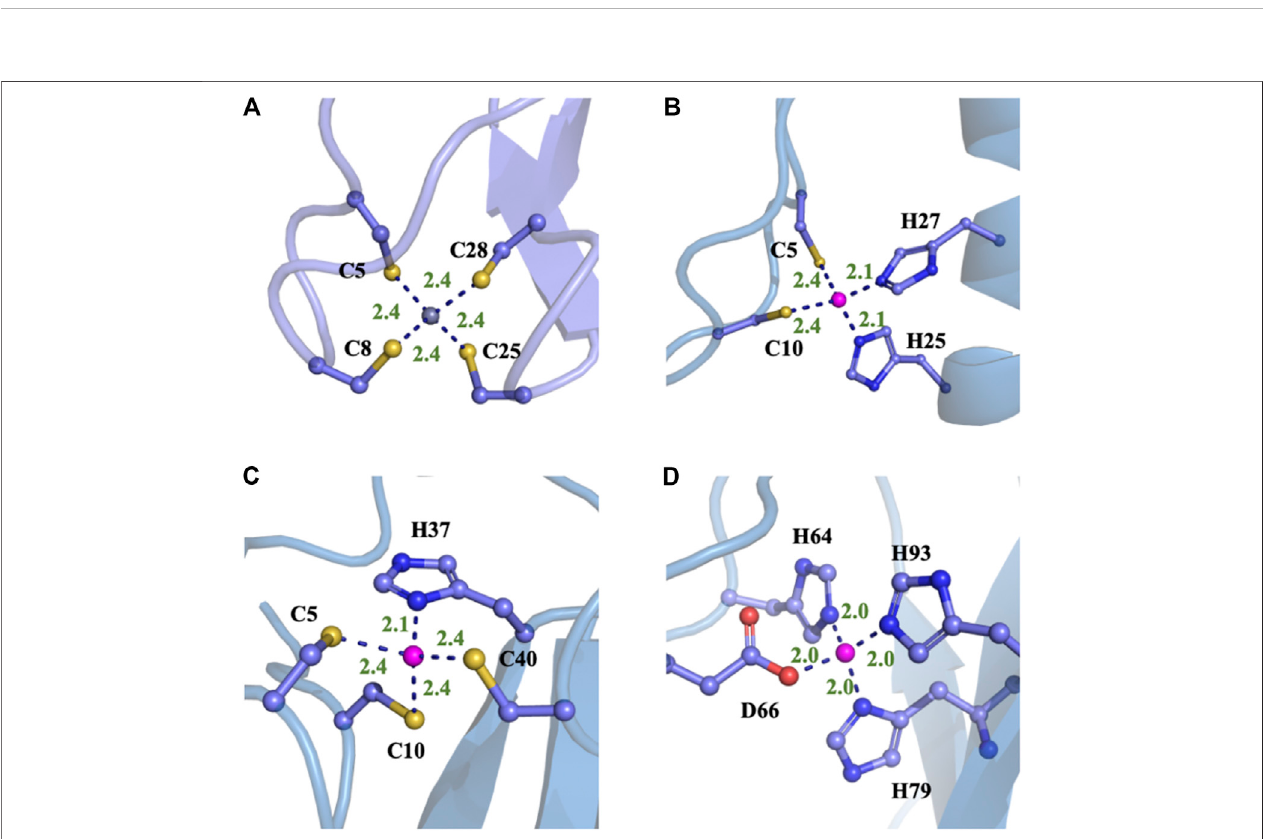
FIGURE 5 | Typical structures of four different proteins with different MBGs after the MD simulations with NN/MM-RESP-MBG models. (A) CCCC type (PDB ID: 1ZIN), (B) CCHH type (PDB ID: 1AAY), (C) CCCH type (PDB ID: 2L30), and (D) HHHO (PDB ID: 1HFS).